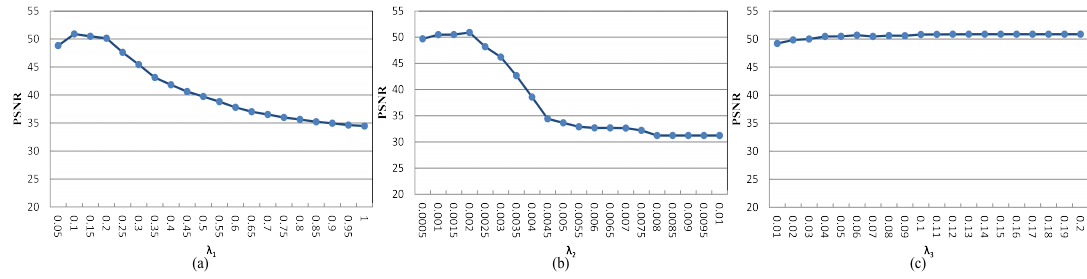
Figure 26. PSNR curves of regulation parameters. ( a ) PSNR curve of parameter λ 1 ( λ 2 = 0.001, λ 3 = 0.05); ( b ) PSNR curve of parameter λ 2 ( λ 1 = 0.15, λ 3 = 0.05); ( c ) PSNR curve of parameter λ 3 ( λ 1 = 0.15, λ 2 =